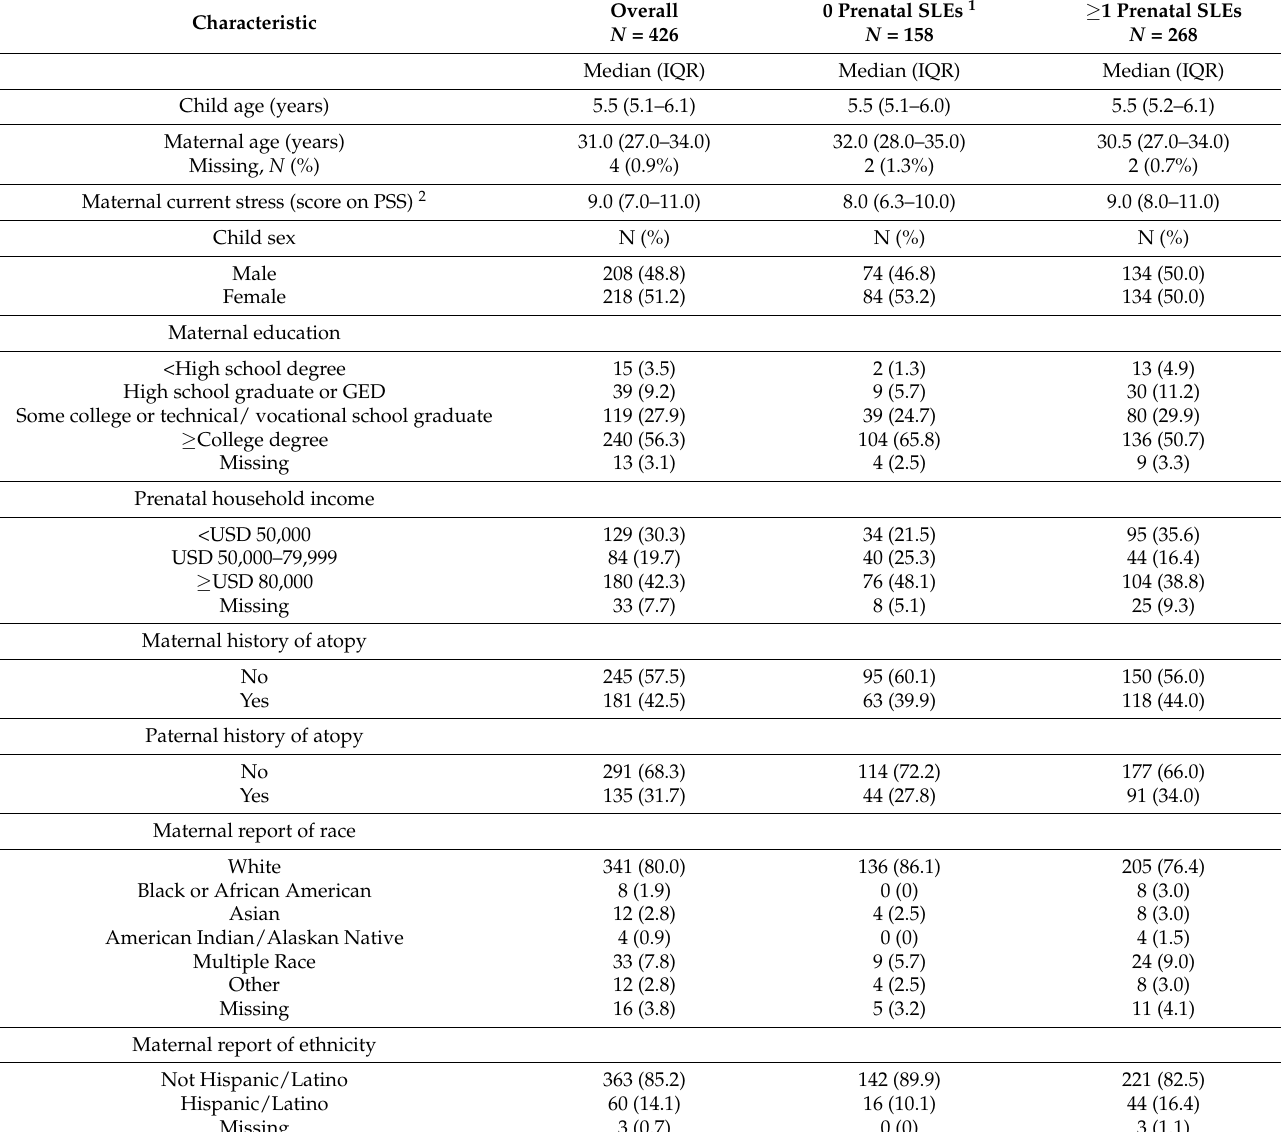
Table 1. Sociodemographic characteristics of dyads enrolled in the Global Alliance to Prevent Prematurity and Stillbirth (GAPPS) Repository with subsequent enrollment in the Environmental influences on Child Health Outcomes (ECHO) PATHWAYS approximately aged 4 to 6-year visit ( N =